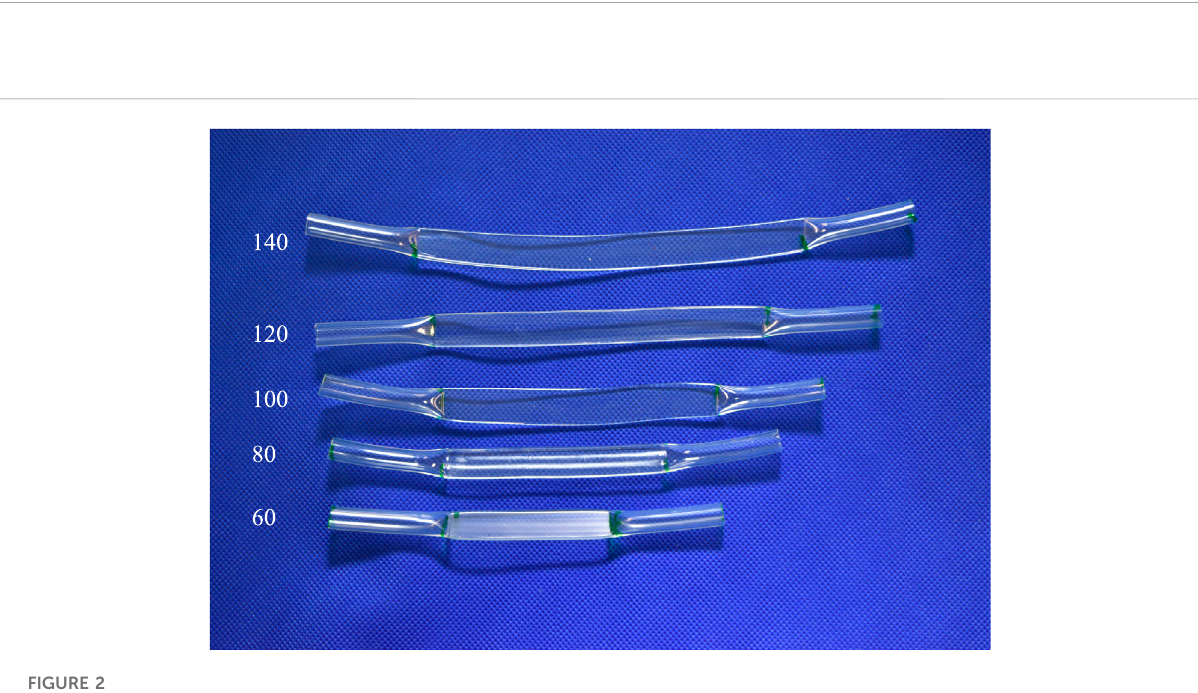
FIGURE 2 Manufactured fl attened